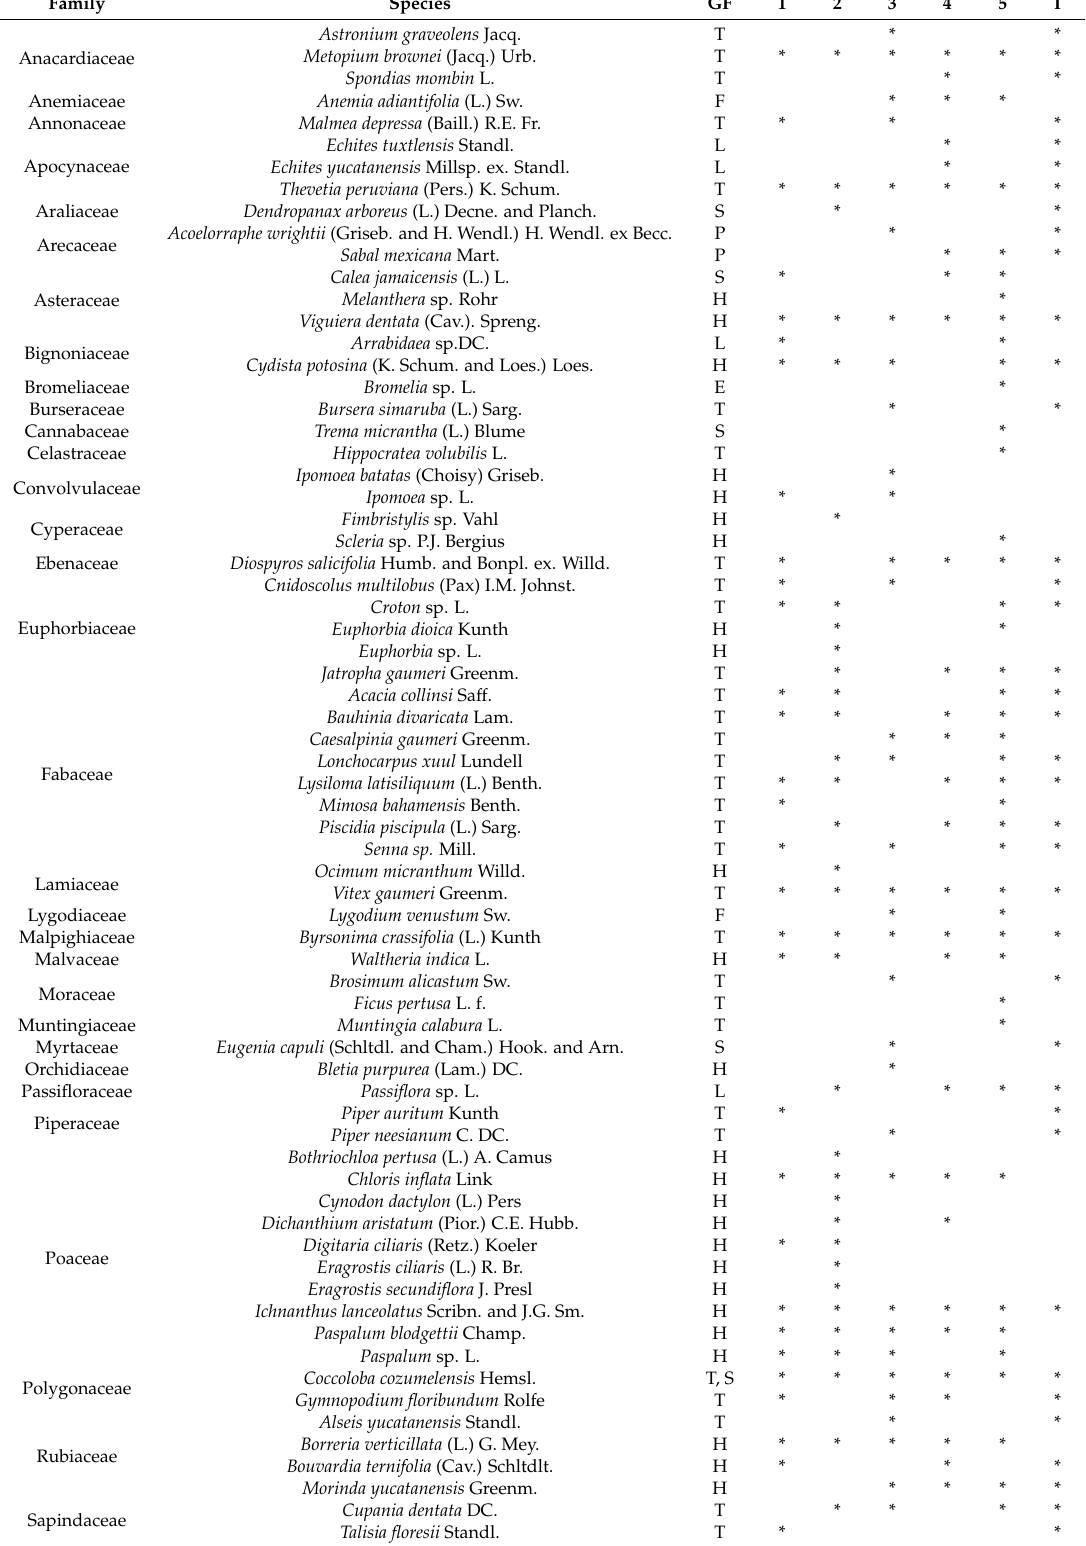
Table 2. The list of species sampled in all quarries and target vegetation, indicating their growth form (GF, T = tree, H = herb, F = fern, E = epiphyte, S = shrub, P = palm; L = liana). 1–5 = marl quarries; T = target